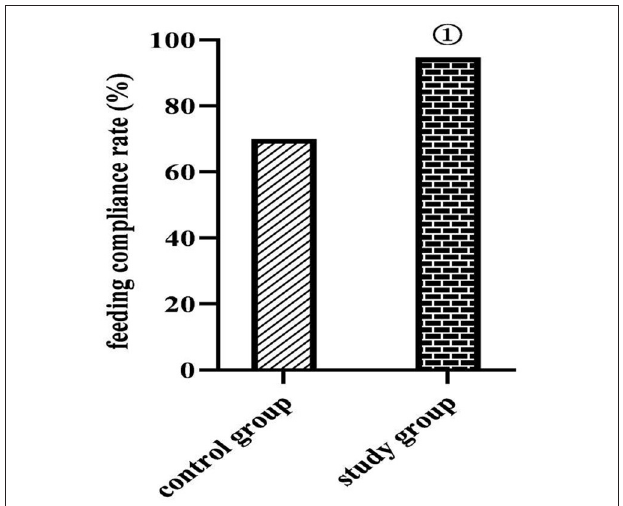
FIGURE 2 | Comparison of feeding compliance rates between the two groups ‹ P < ( n , %). Compared with the control group,